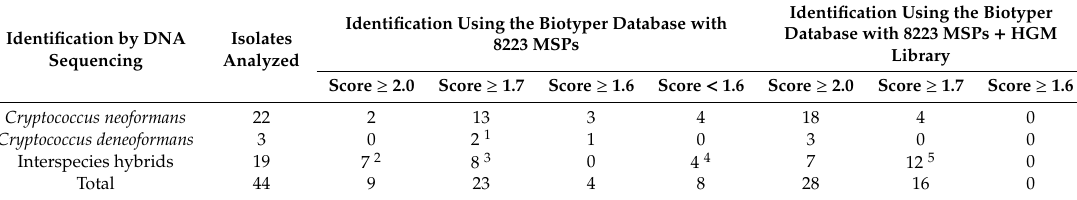
Table 1. Identification of Cryptococcus neoformans , C. deneoformans and interspecies hybrids using MALDI-TOF MS and the Biotyper library alone or in combination with the in-house Hospital Gregorio Marañ ó n (HGM) database. MSP stands for Main Spectra